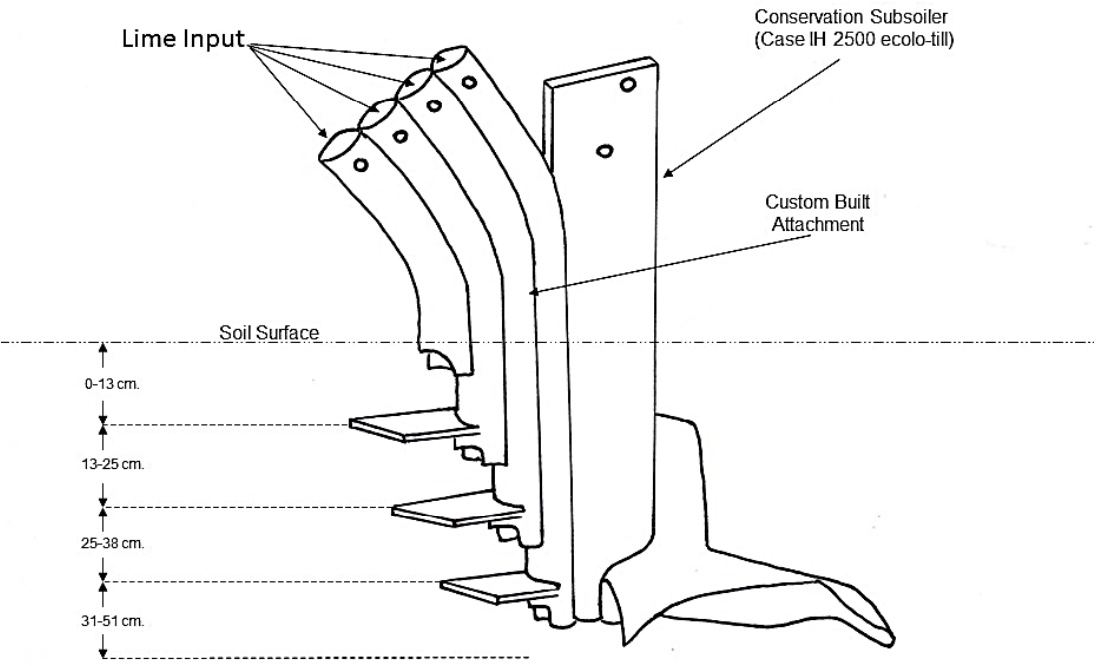
Figure 1. Custom built shank attachment schematics showing the depths at which lime was placed in the soil in relation to the soil surface.